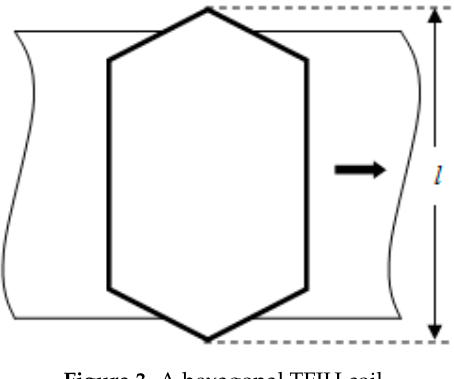
Figure 3. A hexagonal TFIH coil.